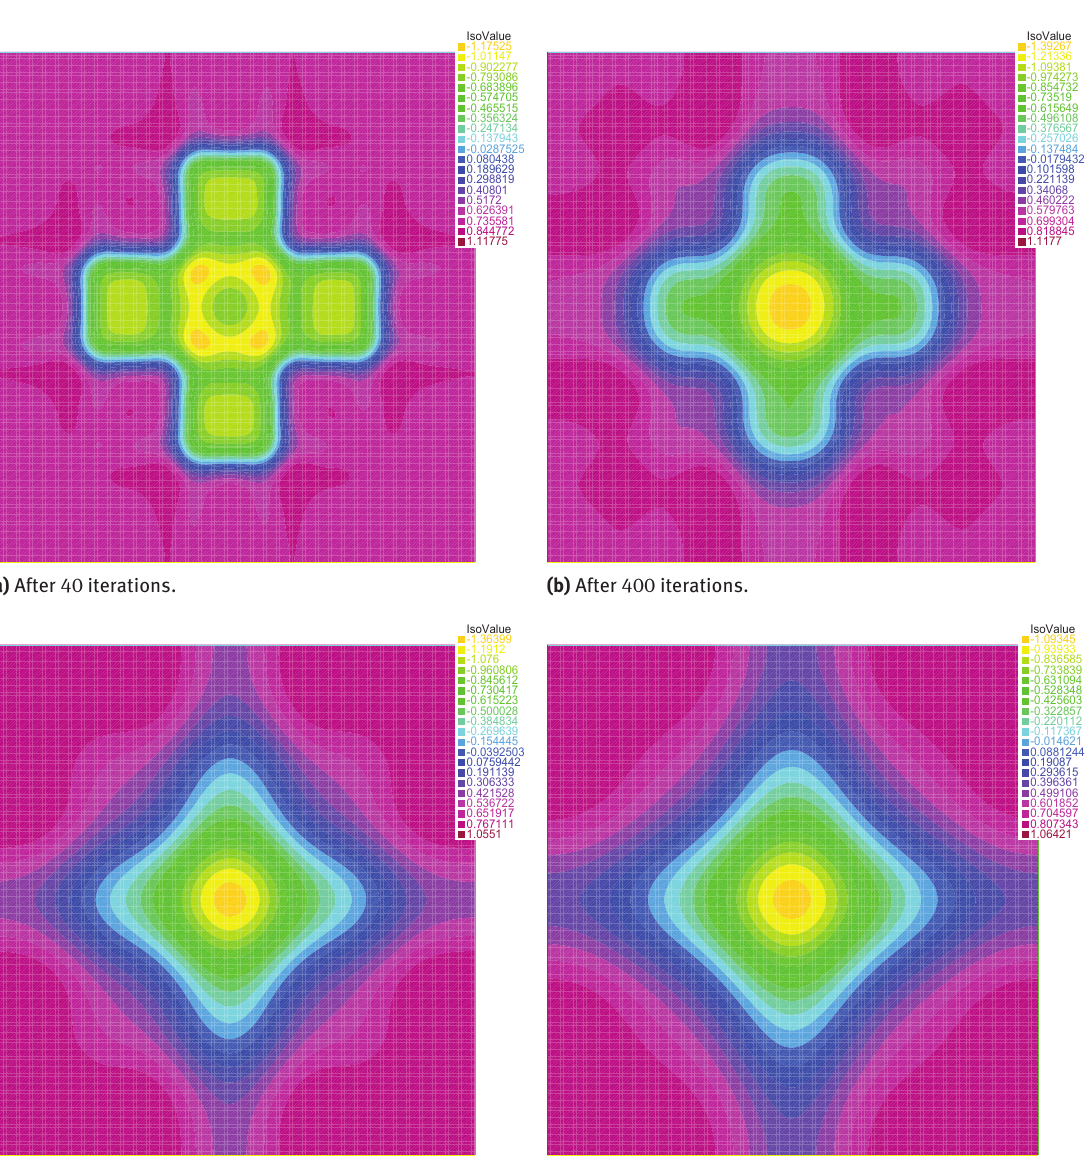
Figure 11: Results for k = 2, dt = 10 − 7